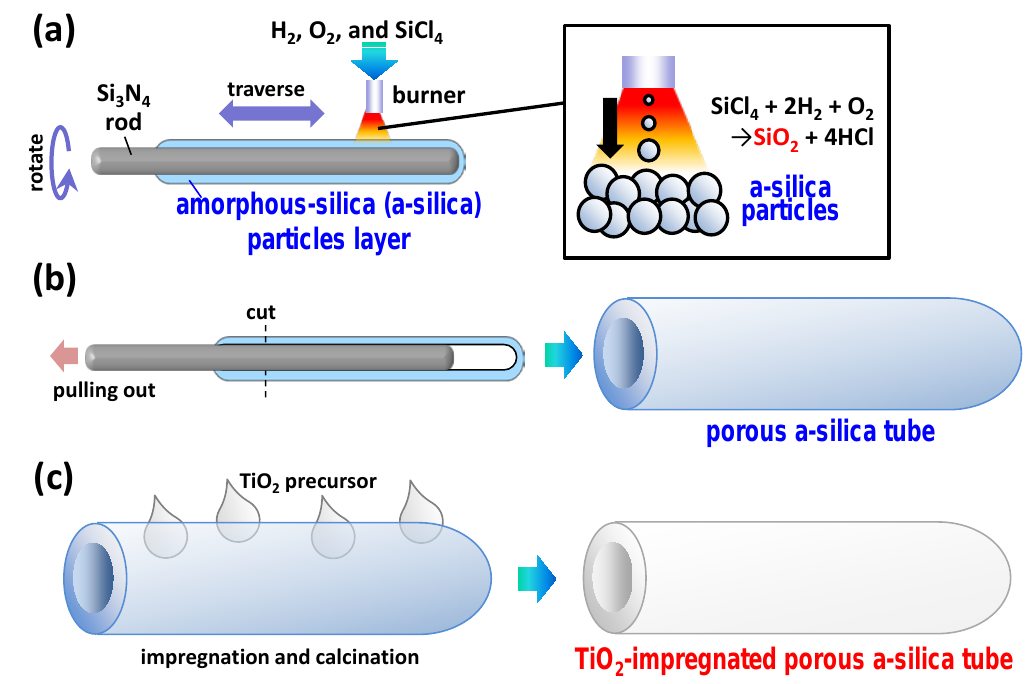
Figure 7. Schematic of the method of fabricating porous TiO 2 -impregnated a-silica tubes.